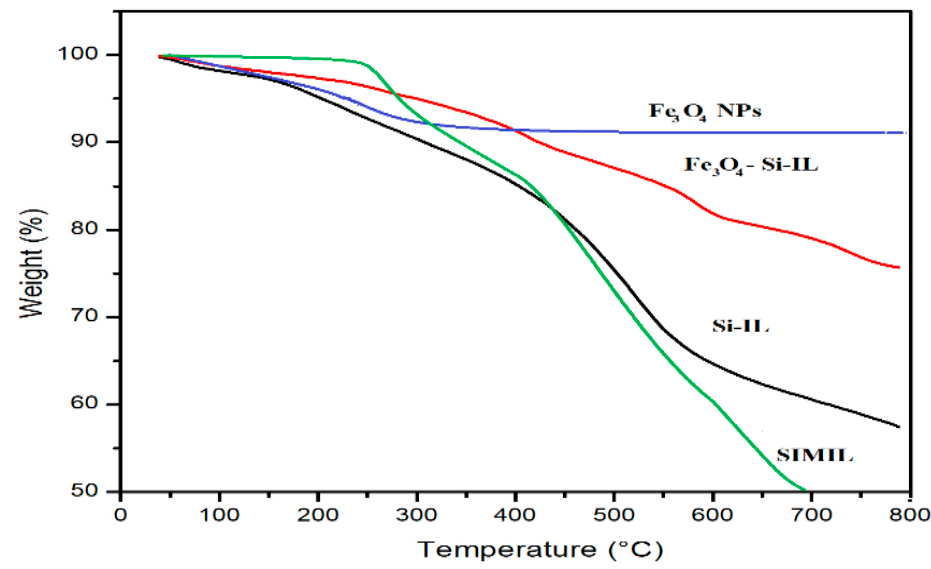
Figure 3. Thermogravimetric analysis (TGA) thermograms of the prepared composites.